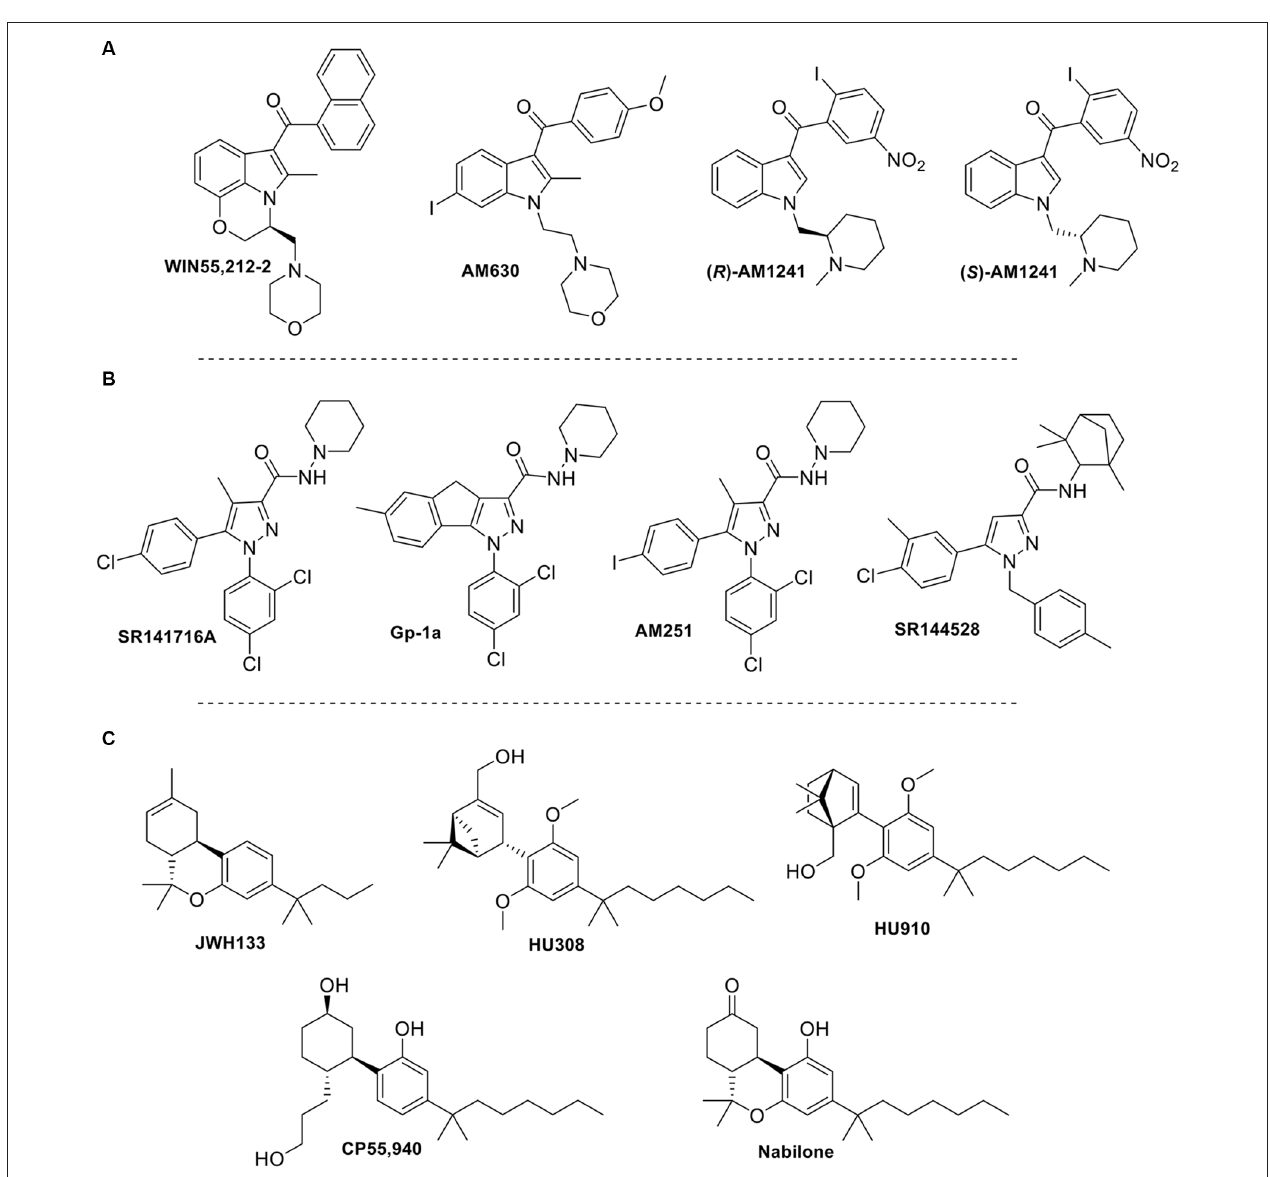
FIGURE 6 | Structure of selected synthetic cannabinoid ligands that target TRP channels: (A) aminoalkyindole derivatives; (B) arylpyrazole derivatives; (C) synthetic phytocannabinoids